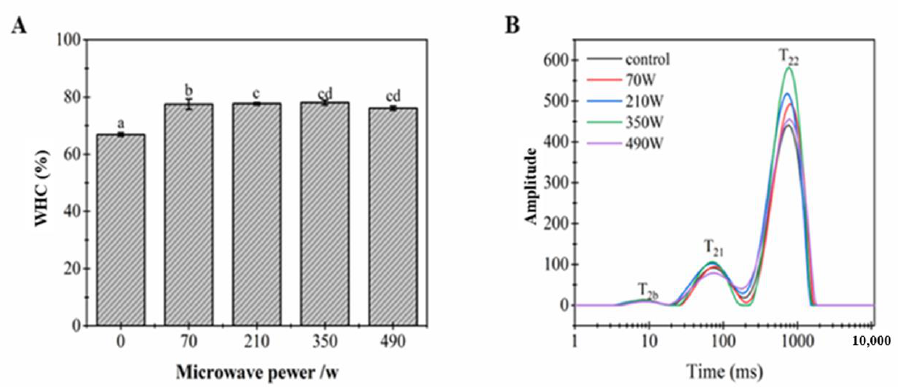
Figure 3. Effect of microwave power on the WHC of lysozyme-oregano essential oil (LZ-OEO) bacteriostatic gels ( A ) and the lateral relaxation curve ( B ). Different letters of “a”, “b”, “c” and “cd” refer to statistically significant differences among the values ( p < 0.05). Table 1. The effect of microwave power on the lateral relaxation time and related peak area